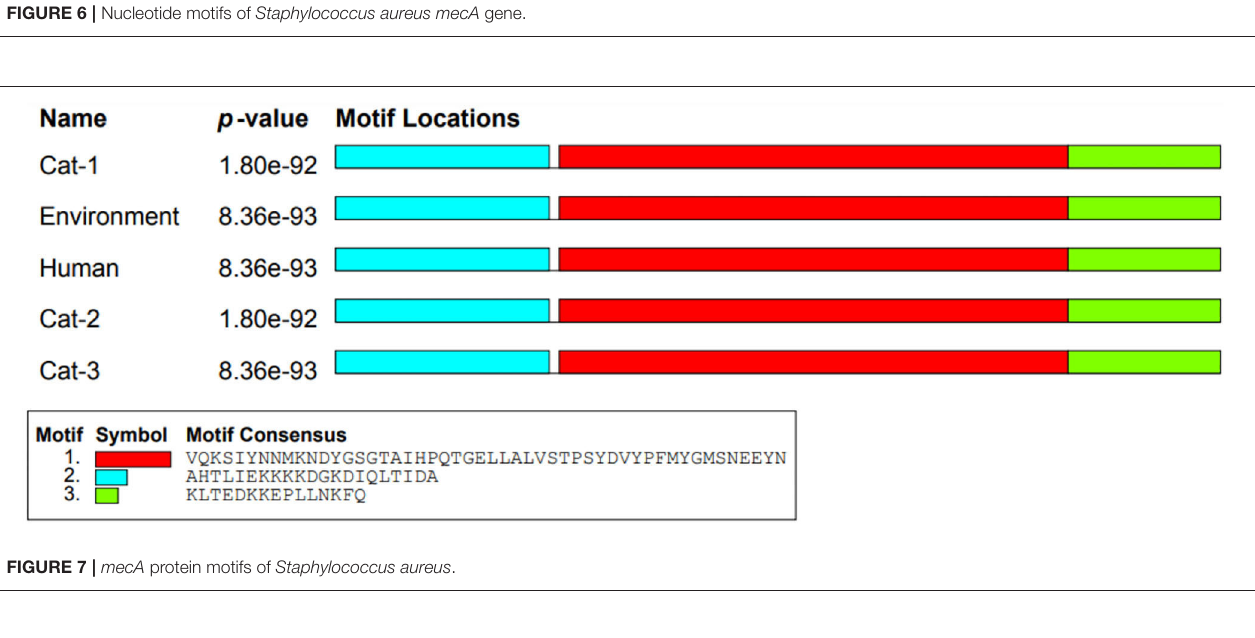
FIGURE 6 | Nucleotide motifs of Staphylococcus aureus mecA gene.